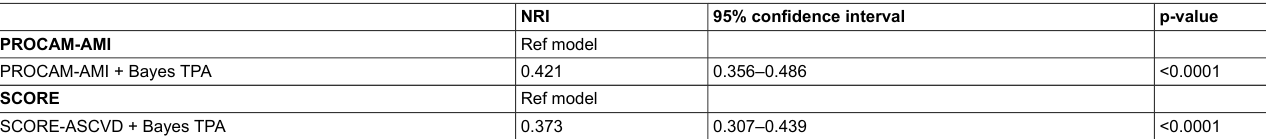
Table S2: Net reclassification improvement (NRI) using post-test risk of PROCAM-AMI and SCORE-ASCVD based on TPA tertiles derived sensitivities and specificities for observed out- come